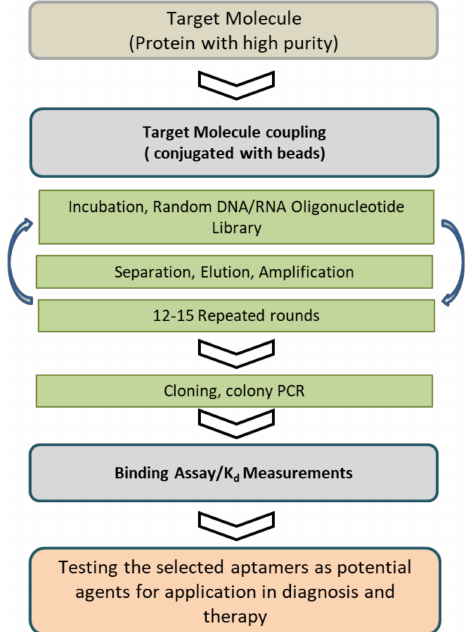
Figure 1. Schematic representation of the protein-based SELEX process used to select an aptamer. The conventional SELEX method is typically carried out using purified target molecules and includes incubating the target molecule. This cycle has to be performed in several rounds, and the binding affinity is monitored until significant binding affinity is reached. High-affinity aptamers for the ligands are isolated and identified by classical cloning and the sequencing results using bioinformatics analysis. The aptamer selection process is followed by selectivity study to the specific target molecule, and the thus identified molecules are used for potential diagnostic or therapeutic applications.